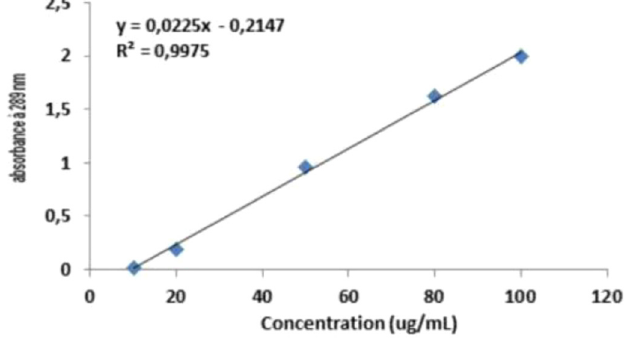
Fig. 3. Linear regression analysis of the calibration curve of Ecstasy in a seizure by UV-Vis spectrophotometer. Each point is the mean ∓ SD of three experiments [15].